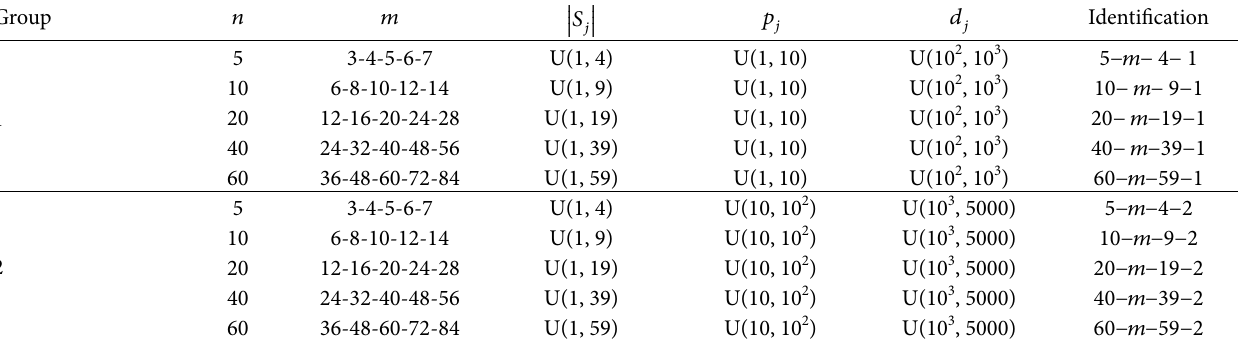
Table 1: Summary of the instances